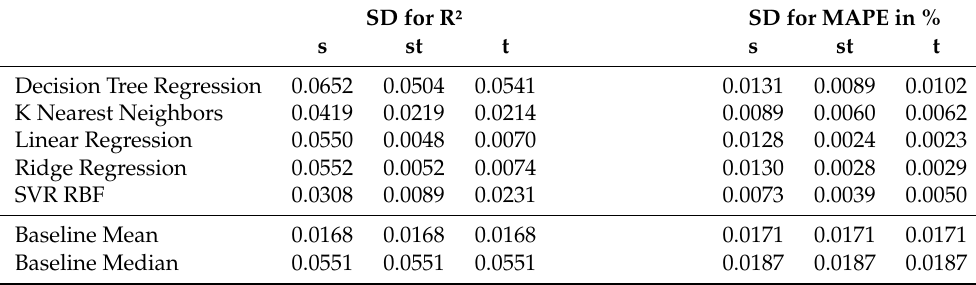
Table A5. Stacking Box Data Set II: standard deviations for the results of Target Weight. SD for R² SD for MAPE in %